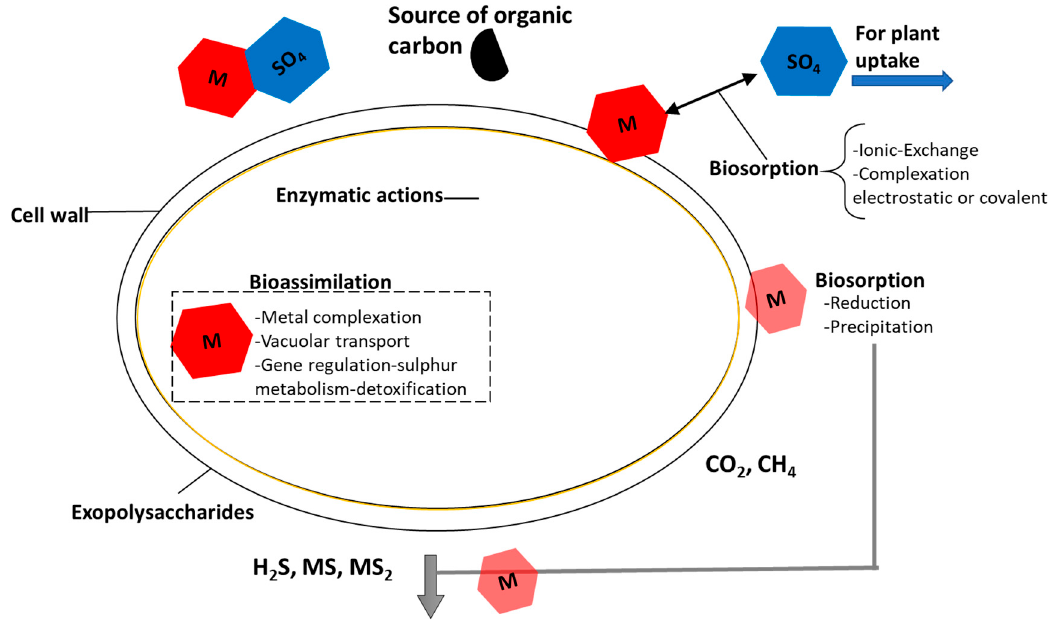
Figure 3. Possible mechanisms of bacteria present in constructed wetlands for the removal, transformation, and tolerance of heavy metals in acid mine drainage